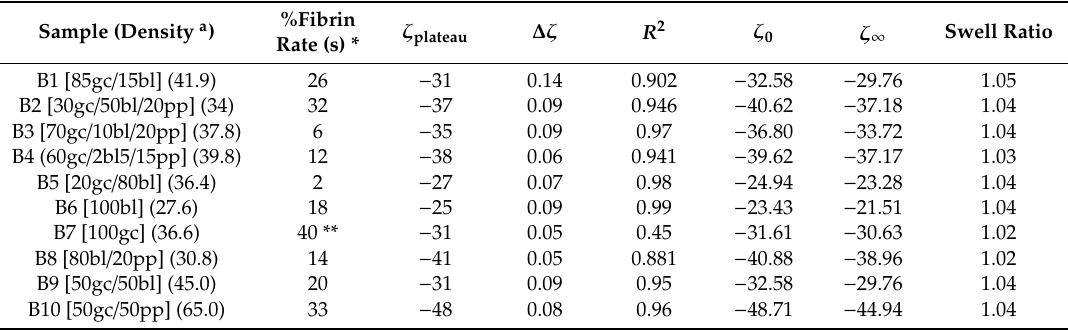
Table 2. List of samples of electrokinetic and time to fibrin formation data from ten compositional blends of unbleached greige cotton / bleached cotton / polypropylene [gc / bl /